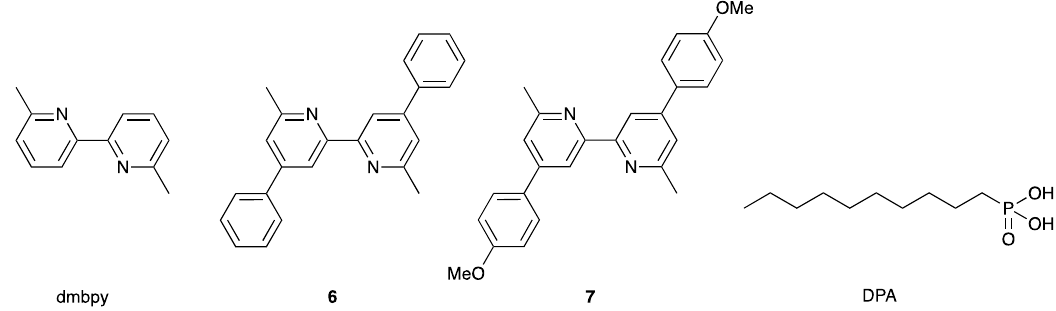
Scheme 6. Structures of ancillary ligands dmbpy, 6 , and 7 , and the co-adsorbent n -decylphosphonic acid (DPA).